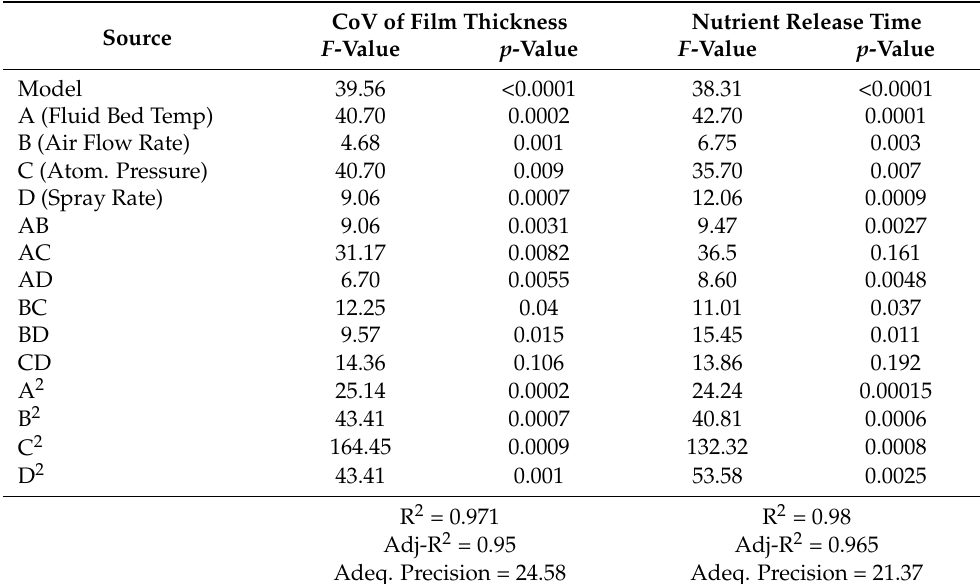
Table 4. Statistical results for the interactive effect of process parameters on the coefficient of variance (CoV) of film thickness and nutrient release